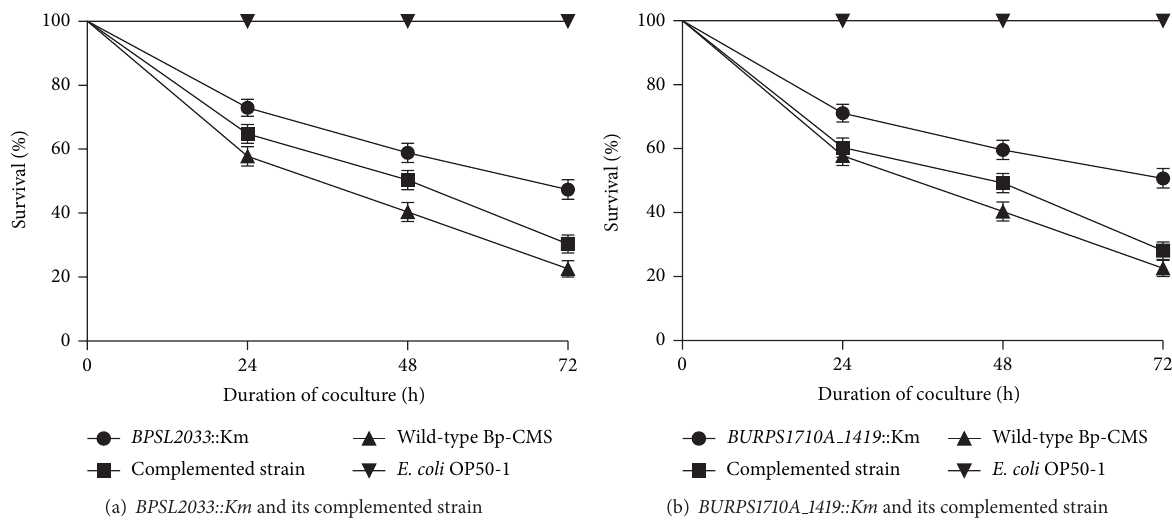
Figure 3: Kaplan-Meier survival curves for C. elegans infected with different strains of B. pseudomallei . Values are the pooled data from triplicate of 3 separate experiments ( 𝑁 = 270 ) ( E. coli OP50-1 was the negative